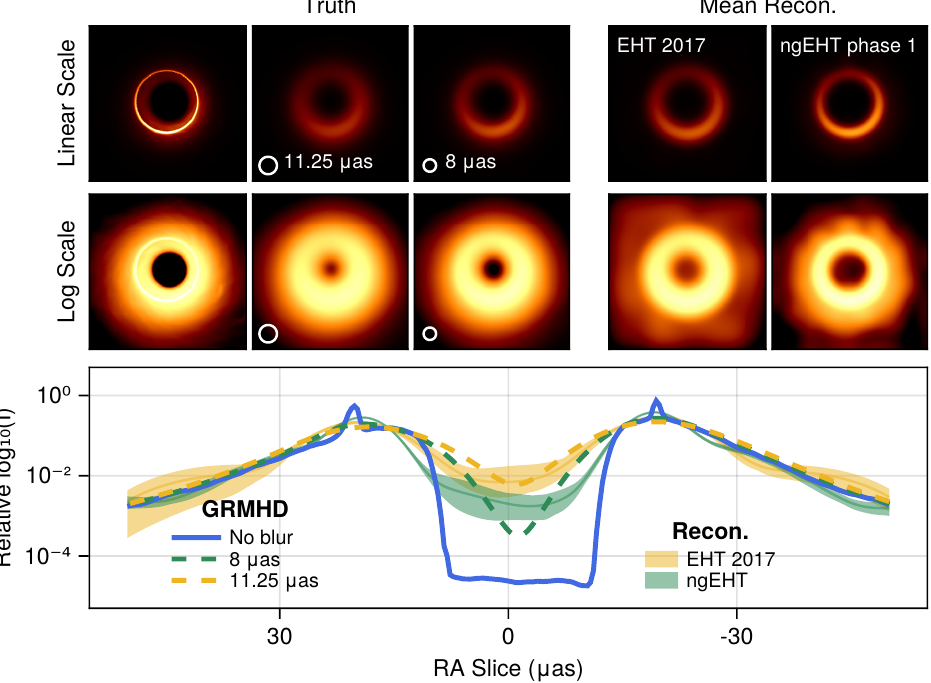
Figure 7. Summary of applying the hybrid model to fit both EHT 2017 and ngEHT phase 1 synthetic data for the time-averaged GRMHD simulation shown in Figure 5. The top row shows the ground truth image with different degrees of blurring (left group) and mean reconstructions using the thick ring hybrid model (right group) on a linear scale. The second row is the same set of images but plotted on a logarithmic scale. The 11 µ as and 8 µ as blurring kernels applied to the GRMHD simulation were chosen to match the raster resolutions of the hybrid models used for the EHT and ngEHT reconstructions, respectively. The bottom row shows the emission profile along the x-axis for the various images in the top two rows. Bands for the reconstructions denote 95% credible intervals (including both the raster and ring